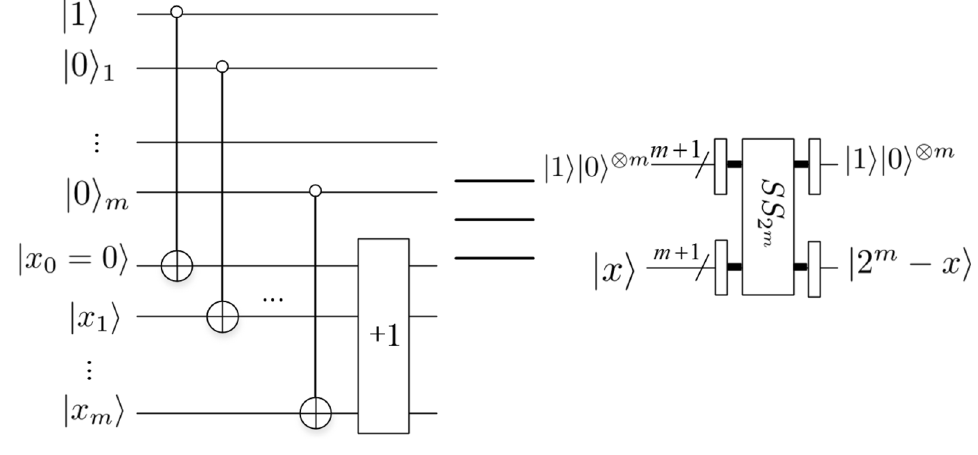
Figure 10. Special Subtractor module 29 .